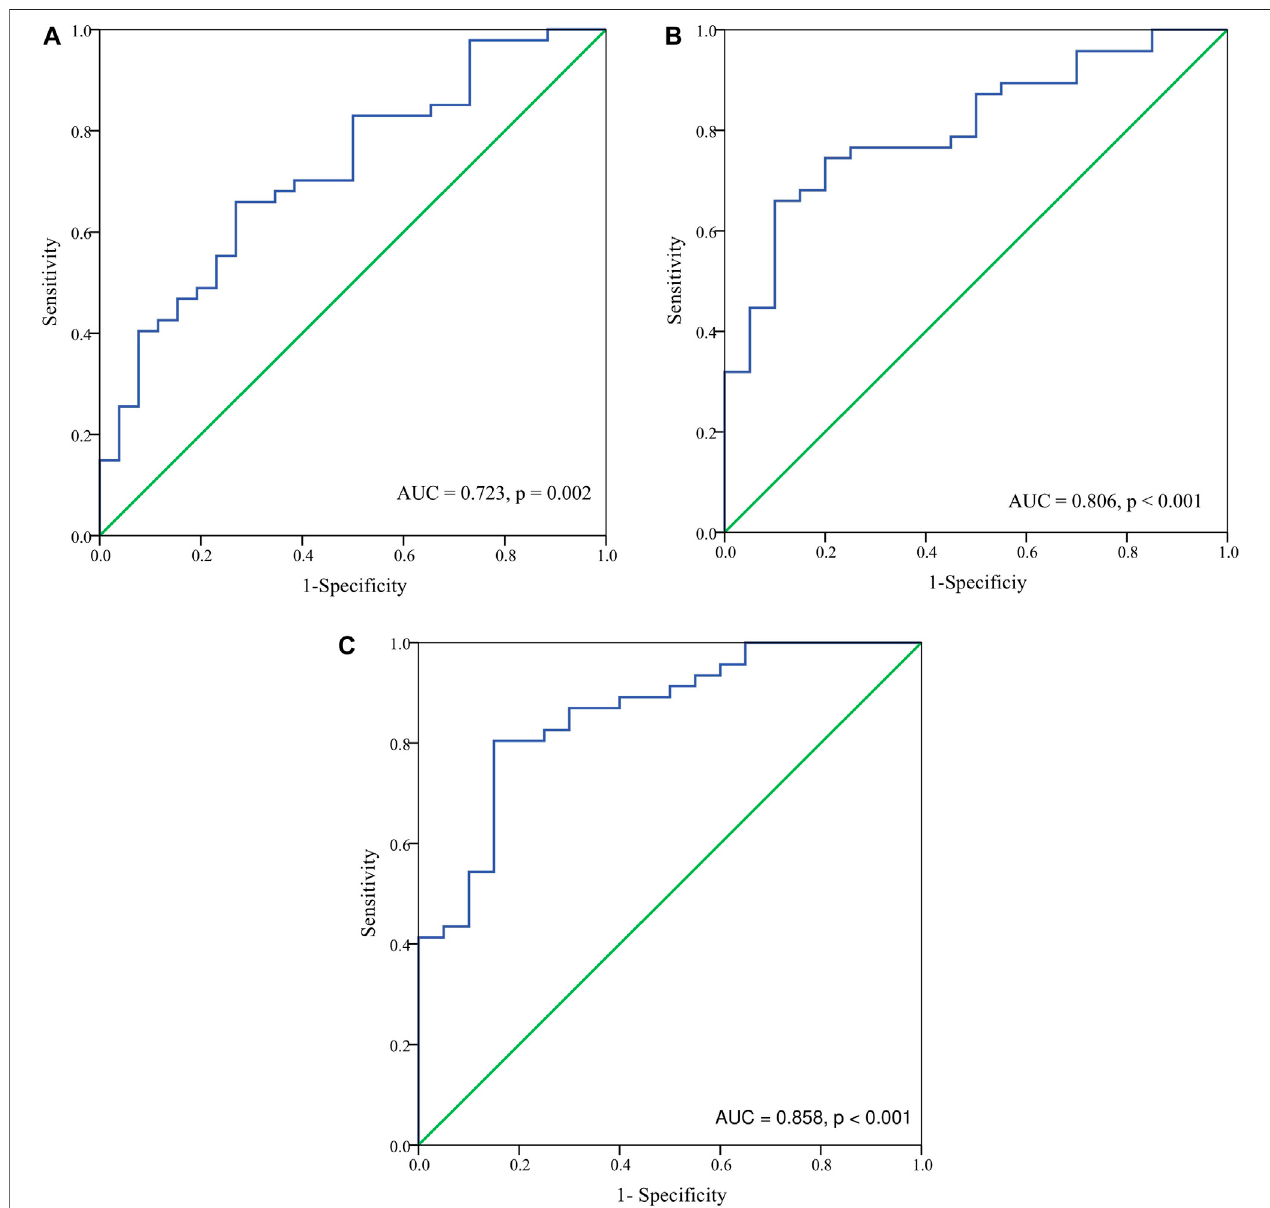
FIGURE 3 | The receiver-operating characteristic (ROC) curve analysis for hemoglobin F (HbF) concentration at different stages in predicting probability of major responders at the sixth month. (A) The ROC analysis for HbF concentration at baseline in predicting probability of major responders at the sixth month. The area under the ROC curve (AUC) was 0.723 ( p (cid:2) 0.002). (B) The ROC analysis for HbF concentration at the third month in predicting probability of major responders at the sixth month. The AUC was 0.806 ( p < 0.001). (C) The ROC analysis for HbF concentration at the sixth month in predicting probability of major responders at the sixth month. The AUC was 0.858 ( p < 0.001).